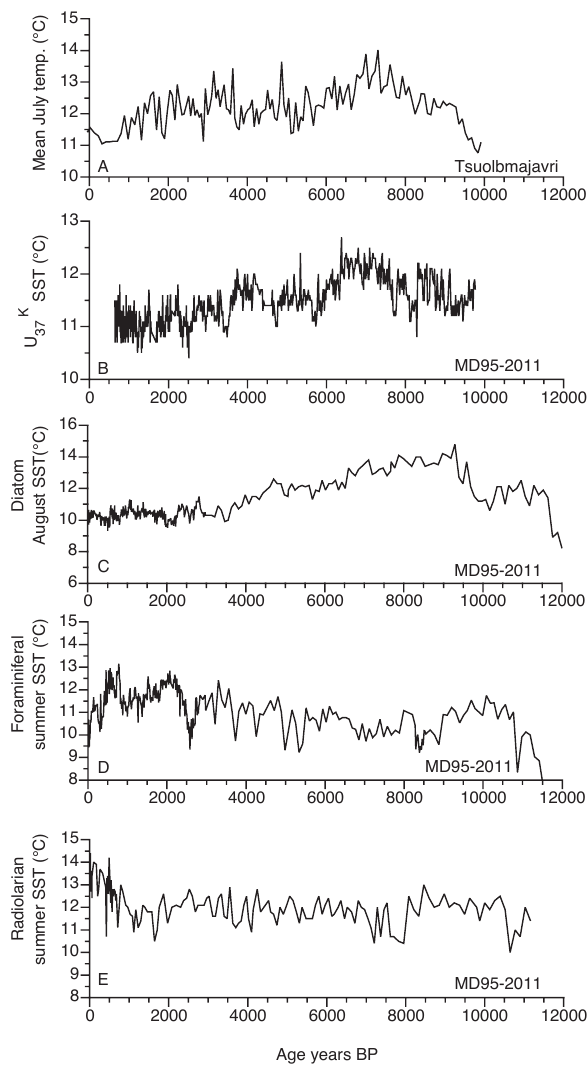
Fig. 6. (A) Mean July temperature based on pollen from Tsuolbma- javri, Finland (Sepp¨a and Birks, 2001). (B) Alkenone derived sea- surface temperatures from the Vøring Plateau (MD95-2011) (Calvo et al., 2002; Jansen et al., 2008). (C) Diatom-based sea-surface Au- gust temperature estimates from MD95-2011 (Birks et al., 2002). (D) Foraminiferal-based transfer function sea-surface temperature estimates for summer (JAS) for MD95-2011 (Andersson et al., 2003; Risebrobakken et al., 2003; this study). (E) Radiolarian- based transfer function sea-surface summer temperature estimates for MD95-2011 (Dolven et al.,